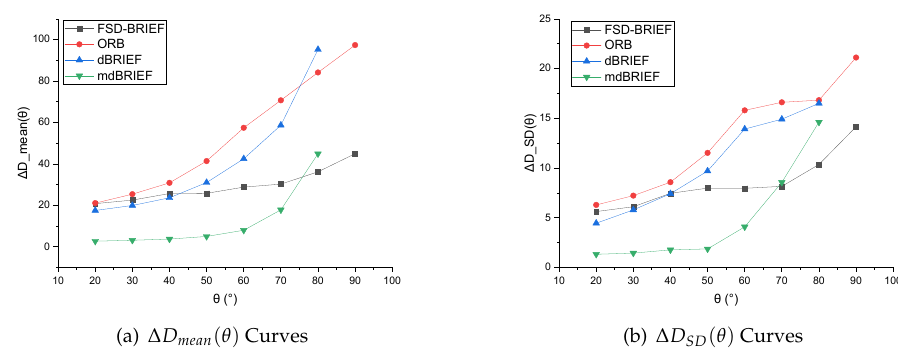
Figure 12. ∆ D − θ curve results in 210° FoV